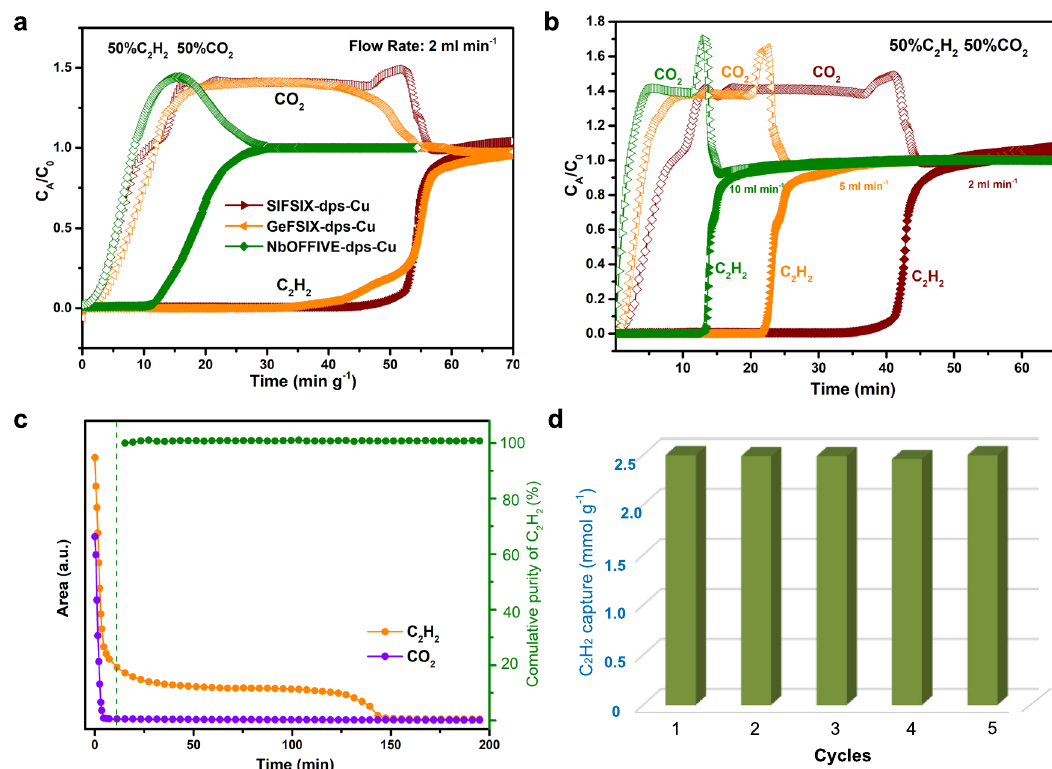
Fig. 4 C 2 H 2 /CO 2 separation. Breakthrough curves of C 2 H 2 /CO 2 (50/50) in a representative MOFs with a 2 ml min − 1 fl ow rate at 298 K. b The breakthrough curves with different fl ow rates at 298 K. c The signals of desorbed gases from SIFSIX-dps-Cu. d Cycling stability of SIFSIX-dps-Cu for C 2 H 2 / CO 2 (50/50)